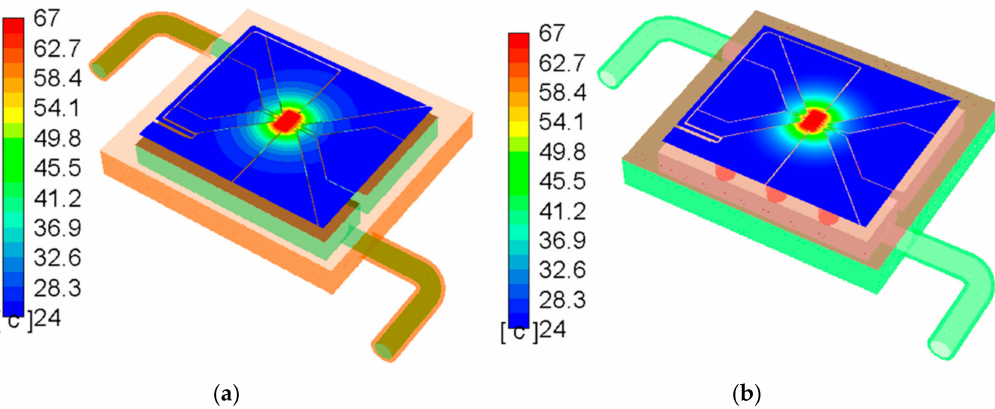
Figure 10. The calculated temperature ( ◦ C) values of PCB upper surface for 3 W LED power ( H = 7 mm, and m = 0.0025 kg / s): ( a ) Block with plane cover; ( b ) Block with finned cover.